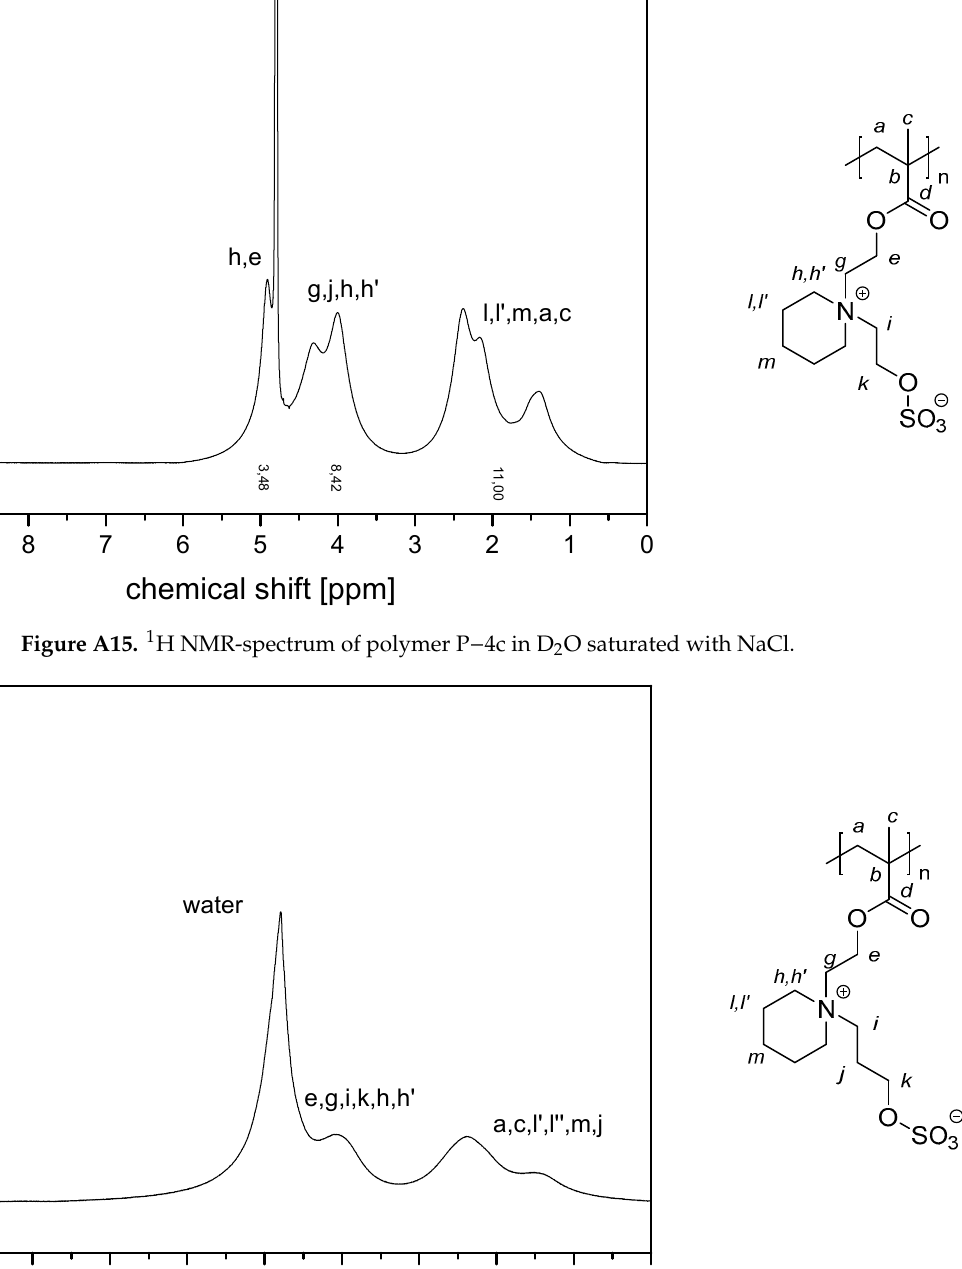
Figure A16. 1 H NMR-spectrum of polymer P − 4d in D 2 O saturated with NaCl.